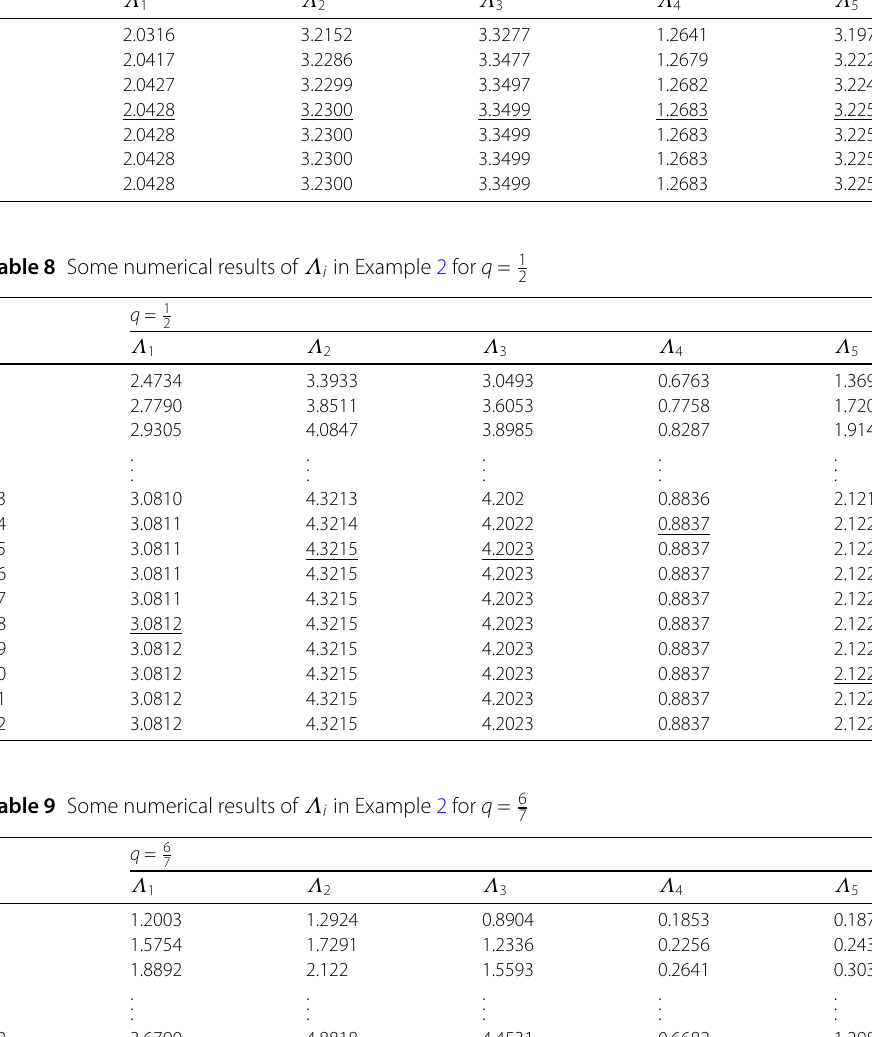
Table 7 Some numerical results of Λ i in Example 2 for q = 1